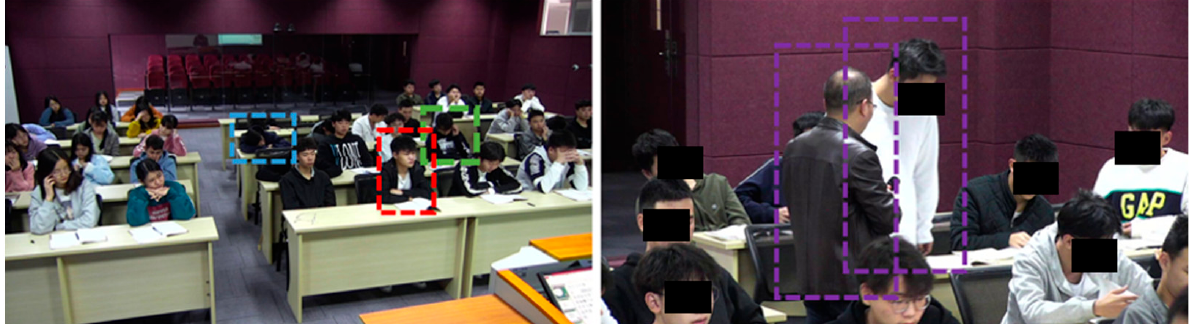
Figure 1. Some representative images in the classroom scenes. The red dashed boxes denote ‘listening’ samples, the green dashed boxes denote ‘looking down’ samples, the blue dashed boxes denote ‘lying down’ samples, and the purple dashed boxes denote ‘standing’ samples.